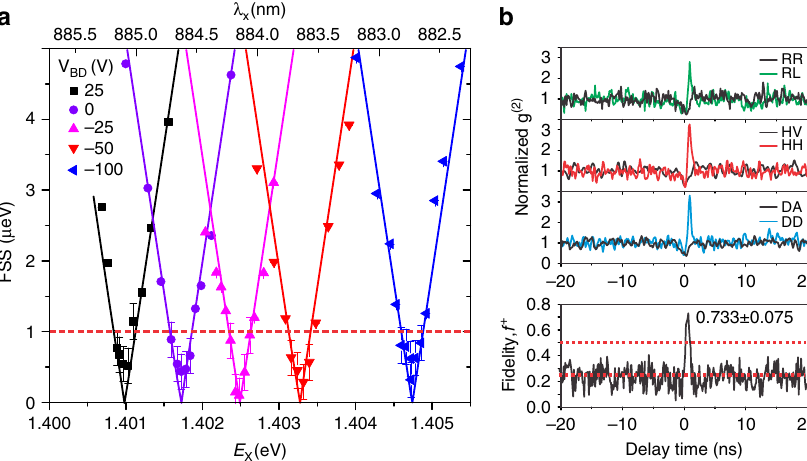
Figure 3 | Independent tunability of exciton wavelength and FSS. ( a ) FSS is plotted as a function of the exciton wavelength l X (energy E X ), at different values of V BD . The solid lines are theoretical fits. In the k . p theory we consider the effect of a pair of orthogonal uniaxial stresses applied to an aligned QD. Exciton energy at which FSS B 0 is tuned by 3.7meV. The dashed line is a threshold of 1 m eV for the entangled photons generations. For FSS of below 1 m eV, the error bars of ± 0.25 m eV are indicated (Methods section). ( b ) Polarization correlation spectroscopy, Methods section, is performed on the biexciton and exciton photons, when the QD FSS is tuned to zero. The normalized coincident counts are given for both co-polarized and cross-polarized photons. We have measured a fidelity f þ of 0.733 ± 0.075 without any background subtraction. The two dashed lines indicate the threshold of 0.5 for the classically correlated light, and the threshold of 0.25 for the uncorrelated